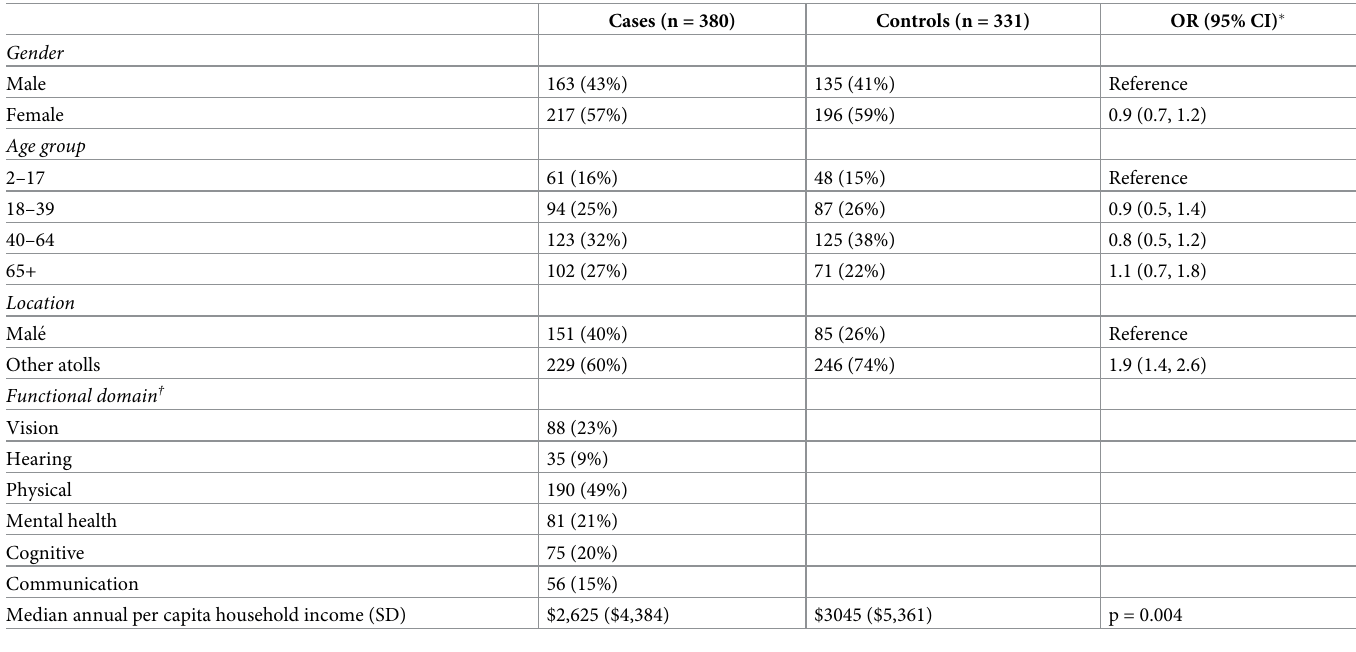
Table 1. Description of the study sample (case-control).